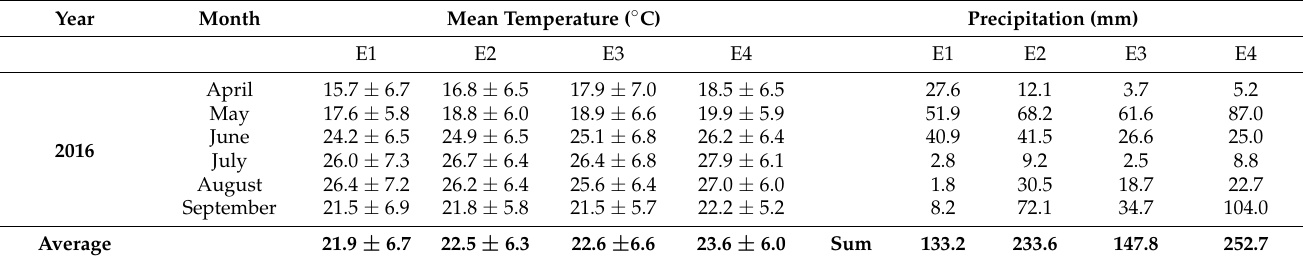
Table 2. Mean monthly temperature ( ◦ C) and precipitation (mm) during the growing seasons of 2016–2020, in the four study areas: Thrace (E1); Macedonia (E2); Central Greece (E3); and Thessaly